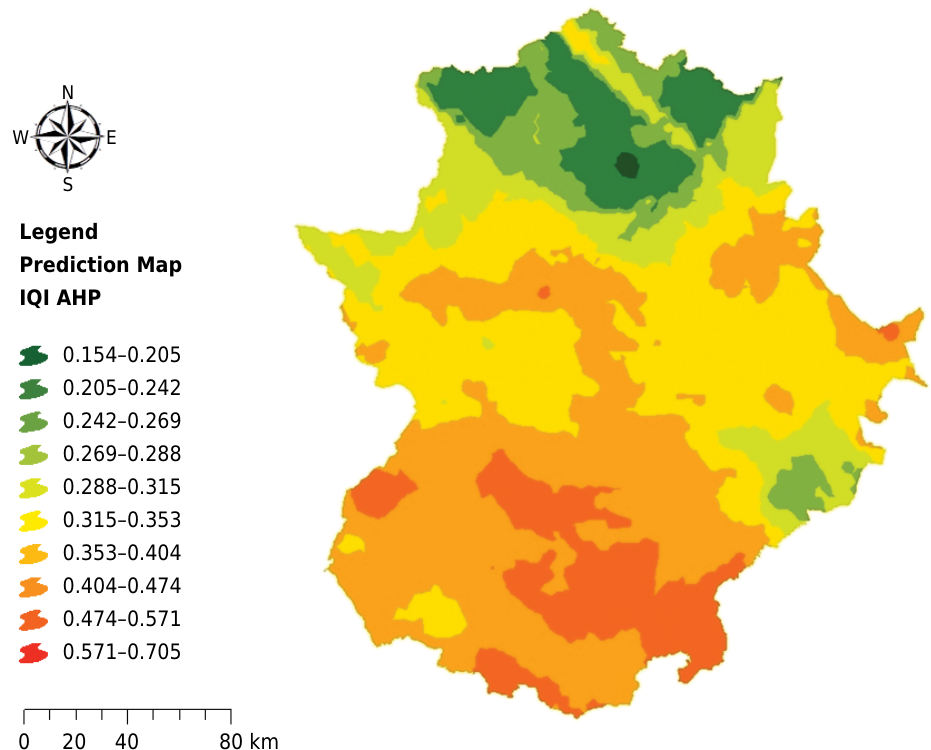
Figure 6. Spatial distribution map of IQI AHP using a kriging interpolation